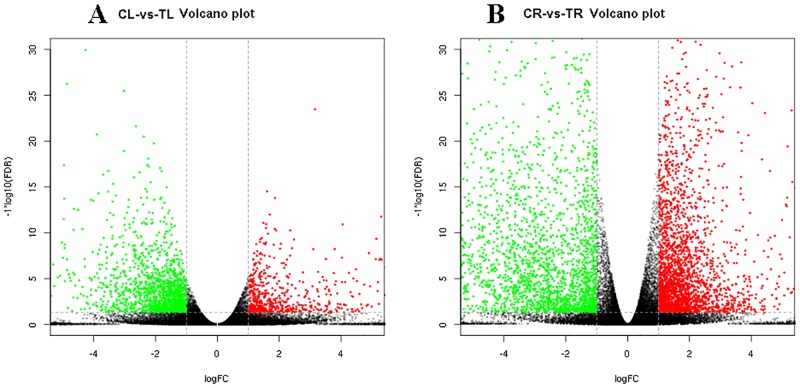
Volcano plots of up-regulated and down-regulated DEGs of leaves and roots from methyl jasmonate treated B. cusia.(A) Volcano plots of CL-VS-TL; (B) Volcano plots of CR-VS-TR, The red (Treated sample is up-regulated relative to controlled sample) and green (down-regulated) points indicate differences in gene expression (threshold of fold change >2 and false discovery rate <0.05), and the black dots indicate no difference between the two samples. The abscissa indicates the log of the fold change and the ordinate indicates the negative Log10 value of the FDR.